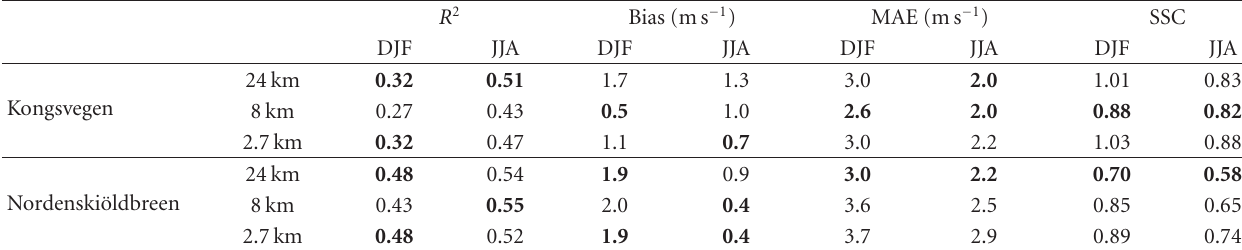
Table 5: Statistical evaluation of wind in summer and winter